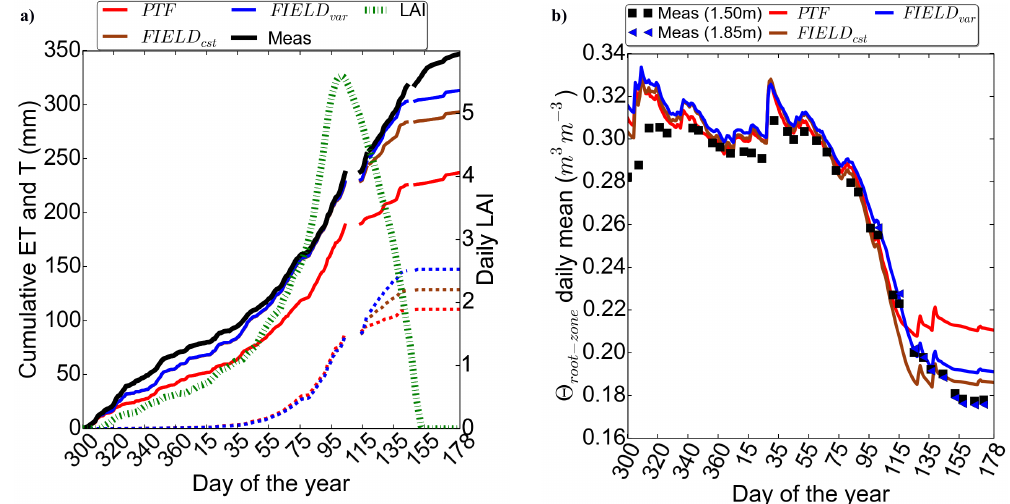
Figure 5. Evolution of (a) measured and simulated evapotranspiration (ET) and (b) measured and simulated root-zone soil moisture ( θ root-zone ) over the wheat cycle in 2006. In (a) , the simulated transpirations ( T ) are represented by dashed lines and ET by solid lines. The LAI cycle is represented by green dash-dot lines. In (b) , Meas (1.50m) is the measured soil moisture integrated between 0 and 1.50m and is used to evaluate the PTF and FIELD cst θ root-zone which were simulated with Z root_zone = 1.5m. Meas (1.85m) is the measured soil moisture integrated between 0 and 1.85m and is used to evaluate FIELD var θ root-zone which was simulated with Z root_zone = 1.85m for wheat crops in